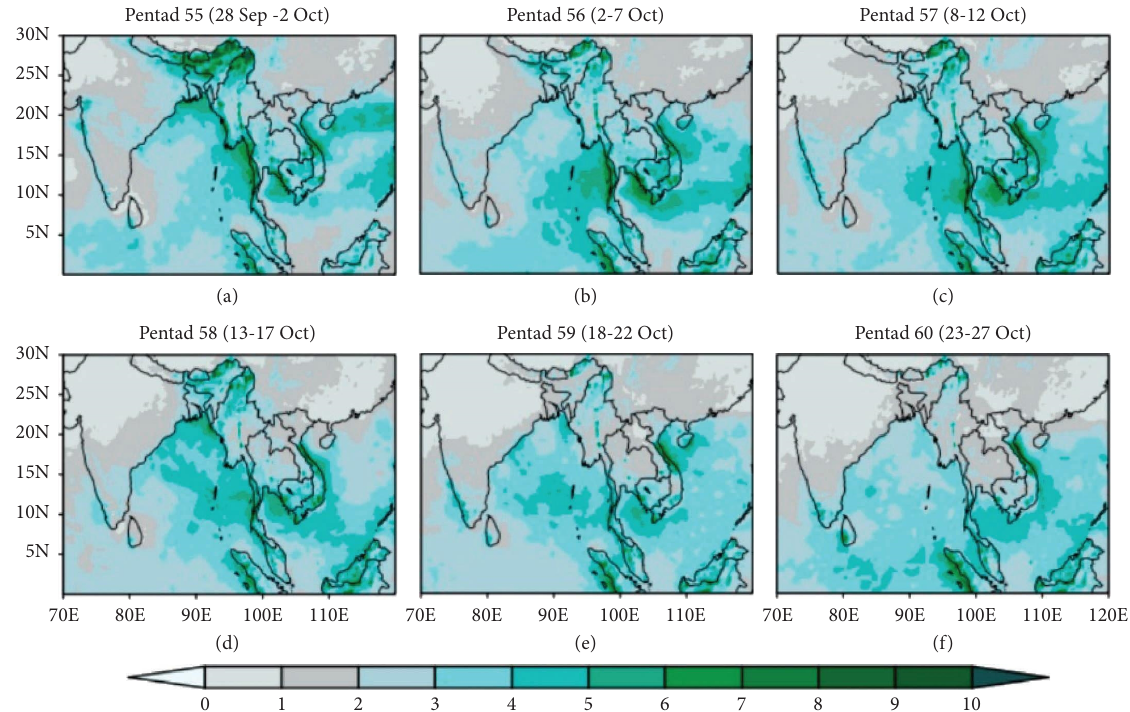
Figure 12: Composite of climatology (1991–2020) net precipitation (mm day − 1 , colour) during the pentads (a) P -55 (Sep 28–Oct 2), (b) P -56 (Oct 3–7), (c) P -57 (Oct 8–12), (d) P -58 (Oct 13–17), (e) P -59 (Oct18–22), and (f) P -60 (Oct 23–27) during monsoon withdrawal period.